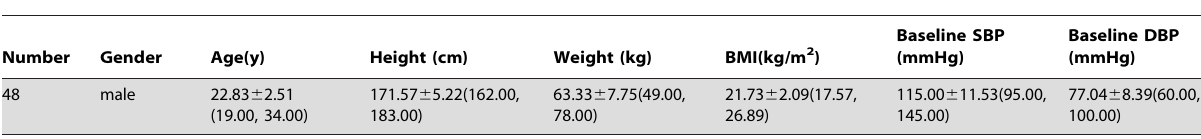
Table 1. The demographics information of the